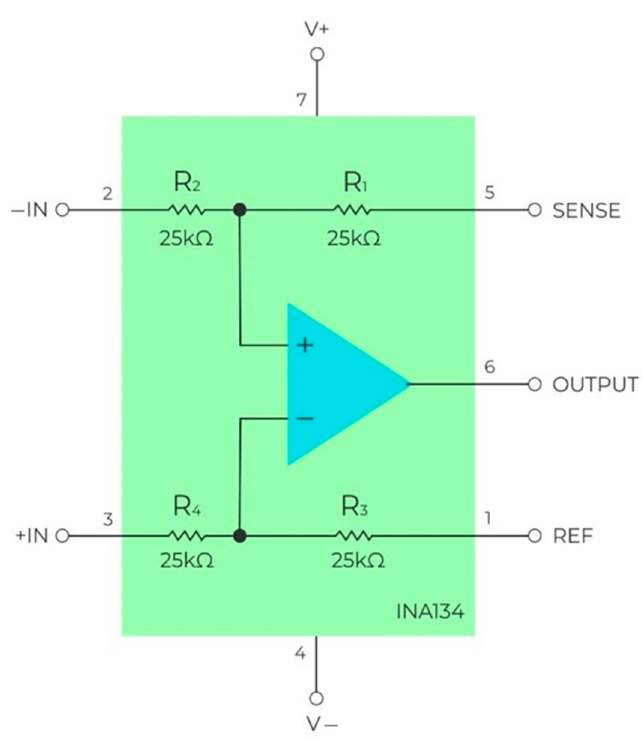
Figure 6. Integral differential amplifier INA134 with laser-tuned high-precision resistors (simplified schematic with actual resistor values) [25].